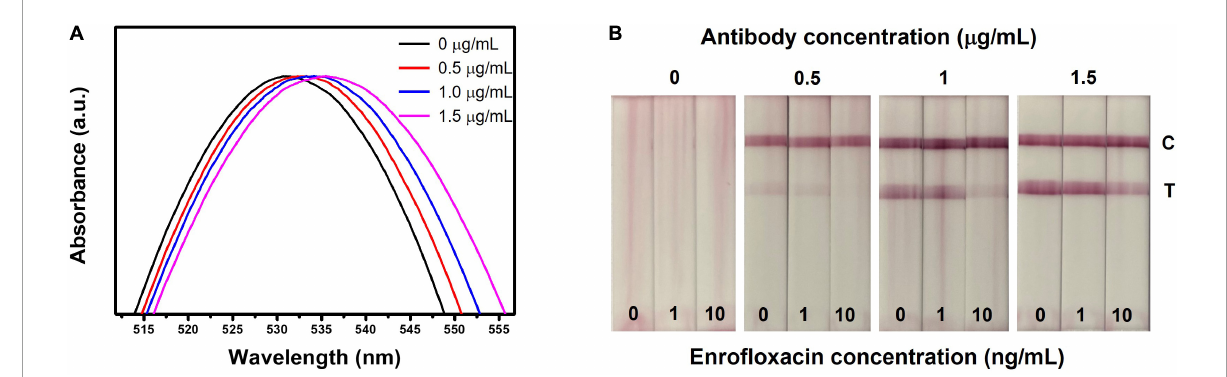
FIGURE3 Optimization of LFIA strip for the detection of ENR. (A) UV-vis spectrum of various concentrations of ENR-Ab conjugated AuNPs. (B) Effect of ENR-Ab with different concentrations (0, 0.5, 1, and 1.5 µ g/ml) in LFIA strips results. The ENR sample concentrations are 0, 1, and 10 ng/ml.